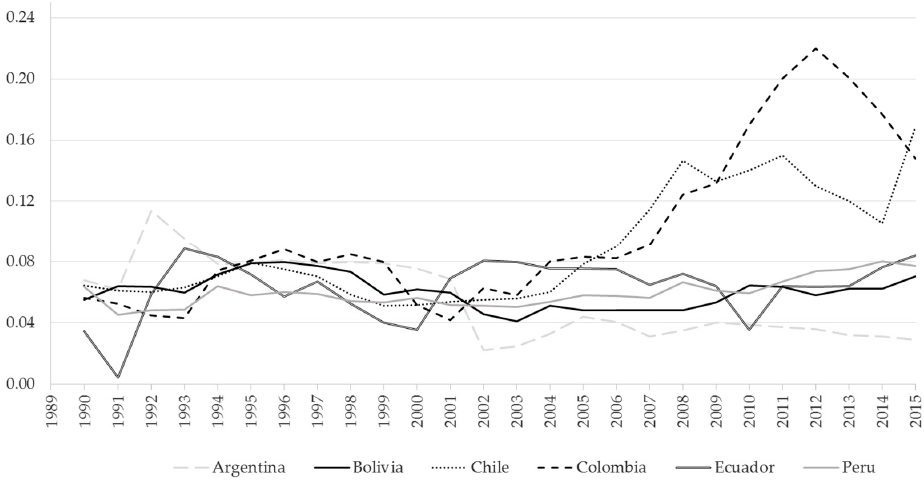
Figure 2. Annual average price of electricity in the industrial sector Source: Energy Information System of Latin America and the Caribbean (sieLAC) of the Latin American Energy Organization (OLADE) [41].